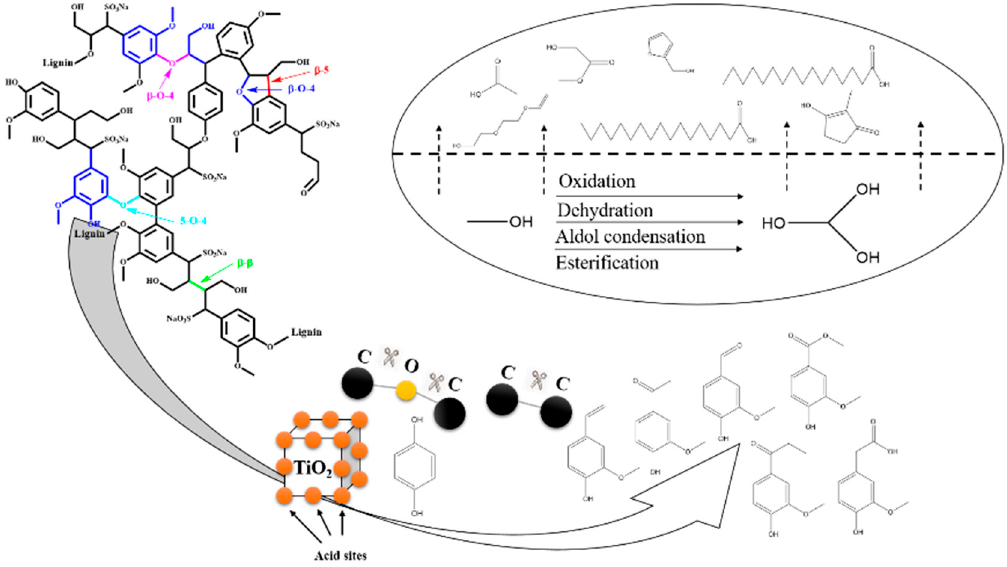
Figure 7. Reaction mechanism.